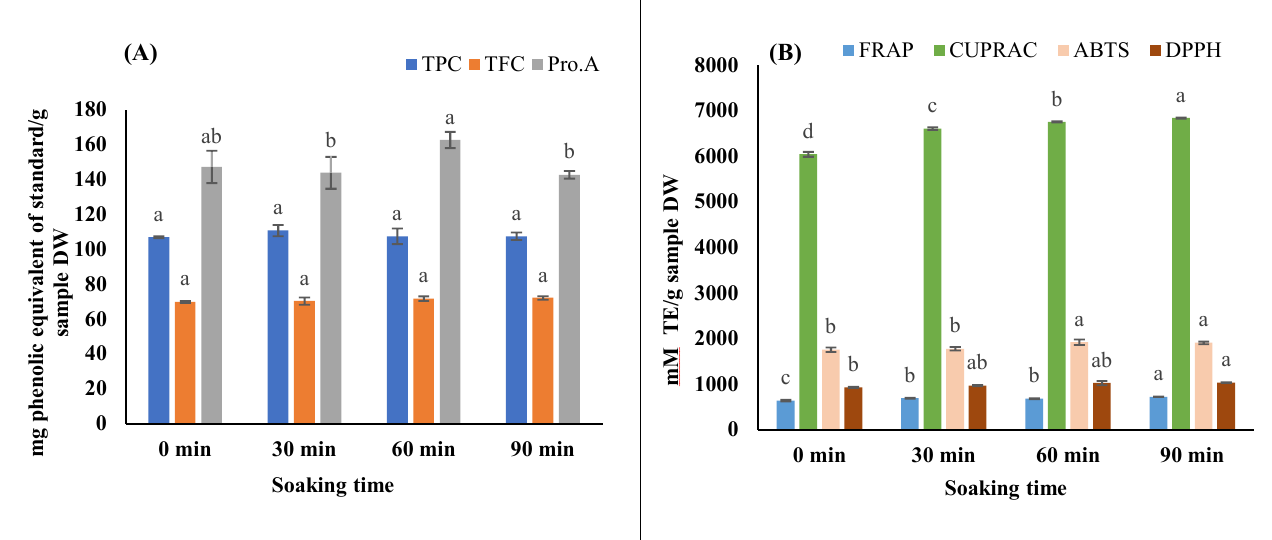
Figure 3. Effect of soaking time on the extraction yield of ( A ) phenolic compounds, and ( B ) antioxidant capacities. The column with same superscript for an individual assay are significantly ( p < 0.05) different. For TPC, mg phenolic equivalent of standard/g sample DW = mg gallic acid equivalent/g sample in dry weight; for TFC and Pro.A, the mg phenolic equivalent of standard/g sample DW = mg catechin equivalent/g sample in dry weight.